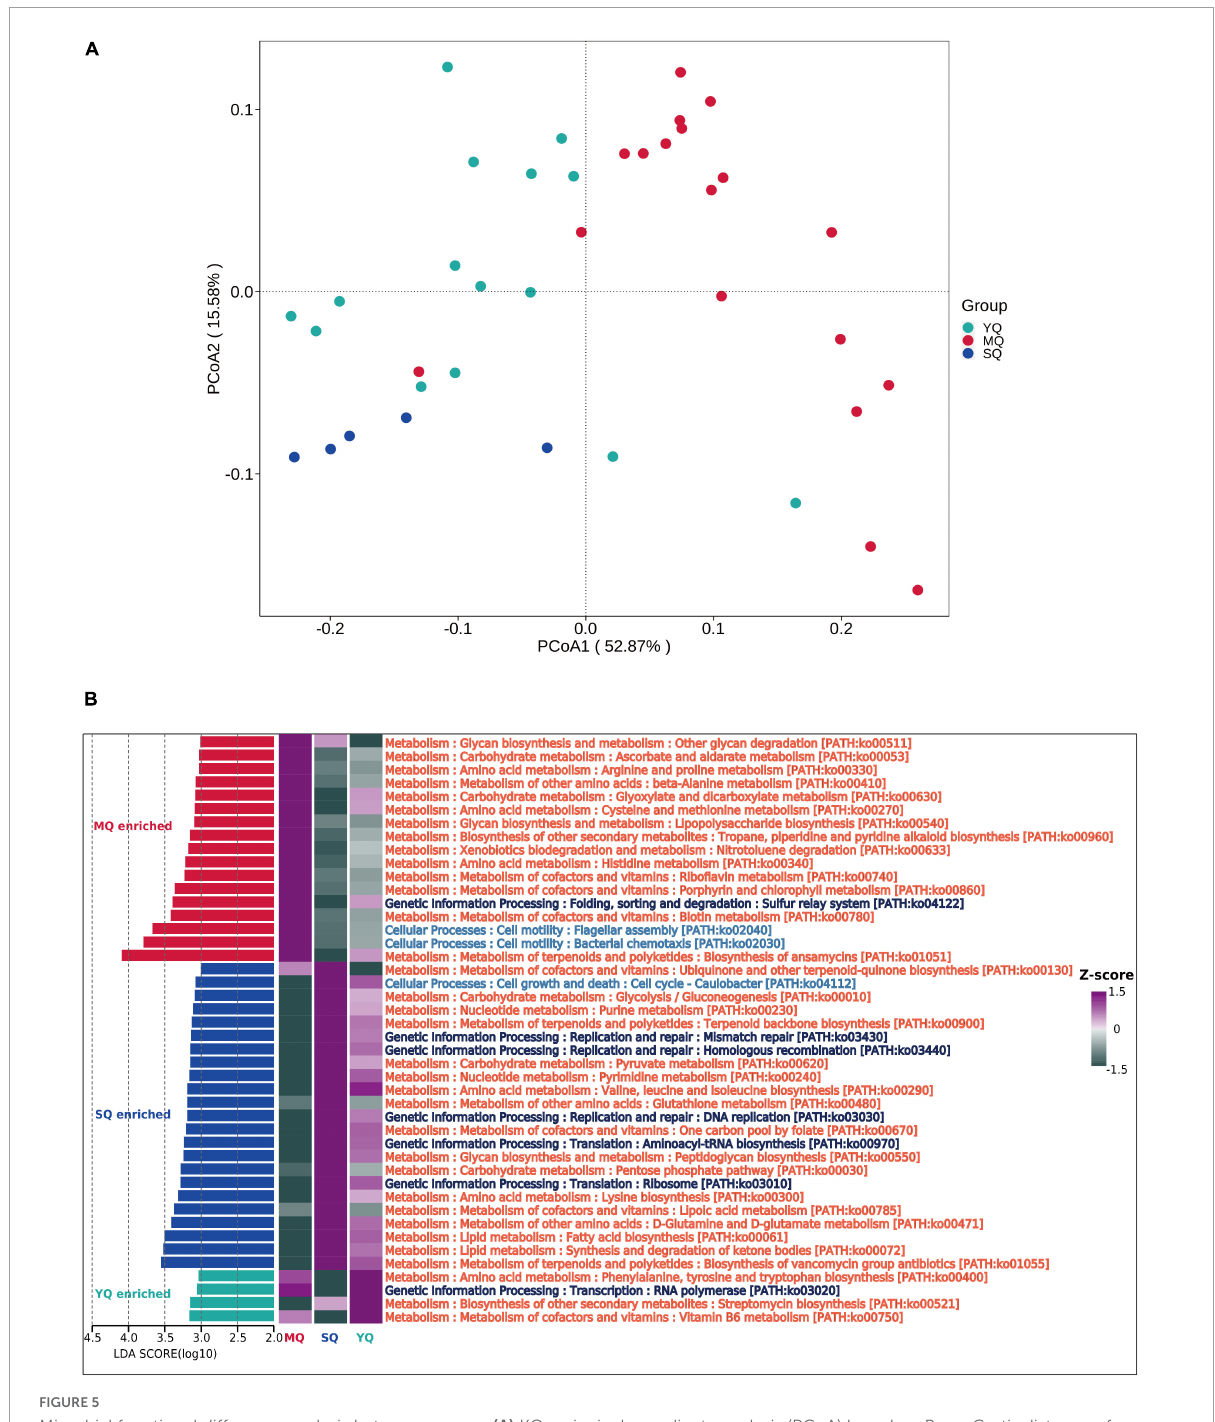
FIGURE5 Microbial functional difference analysis between groups. (A) KOs principal coordinate analysis (PCoA) based on Bray–Curtis distance of predicted KO abundance. (B) Difference in the KEGG pathway identified by LEfSe (LDA score ≥ 3.0 and p < 0.05) between MQ, SQ, and YQ. Heat maps of differential pathways enrichment analysis based on KEGG. MQ, raptors; SQ, waders; YQ, waterfowl.